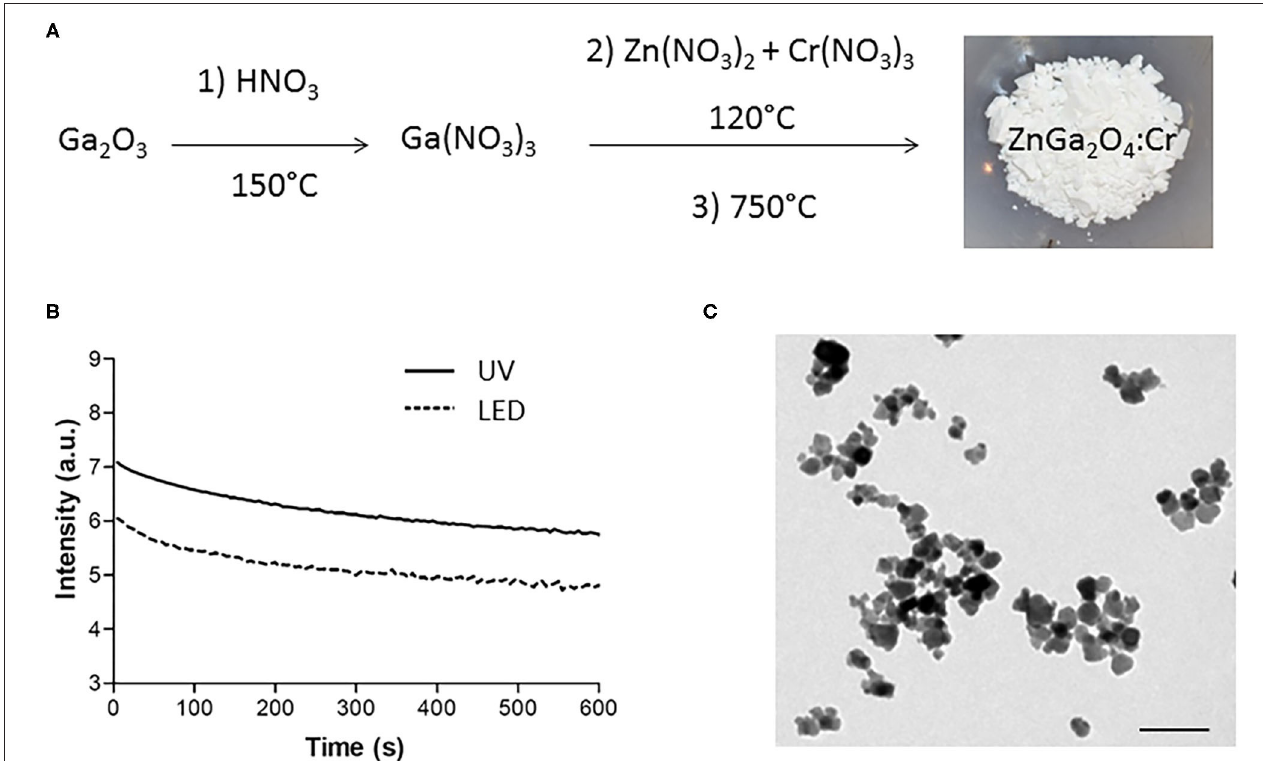
FIGURE 1 | Synthesis and characterizations of ZnGa 2 O 4 :Cr (ZGO). (A) Three-step synthesis of ZGO. (B) Optical properties of ZGO powder after UV and visible excitation. (C) TEM of nanosized ZGO-OH (scale bar = 80nm).